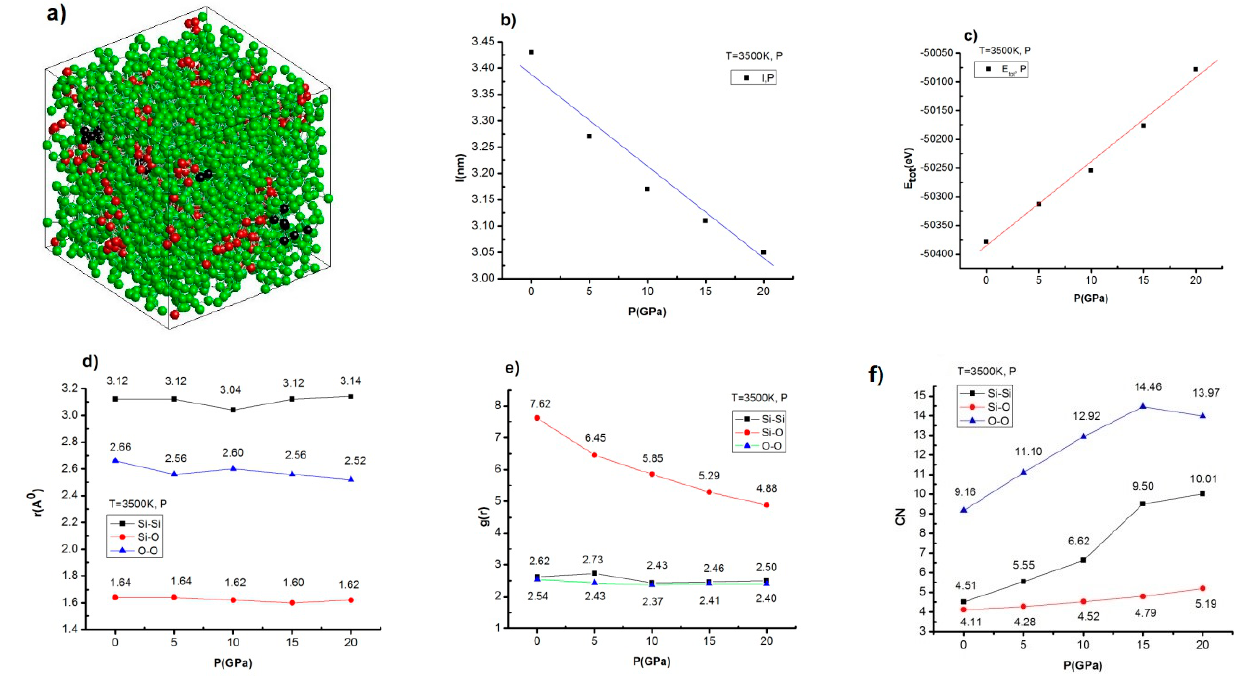
Figure 5. Shape ( a ), l ( b ), Etot ( c ), r ( d ), g(r) ( e ), coordinate number ( f ) of bulk SiO2 at T = 3500 K with different values of p .